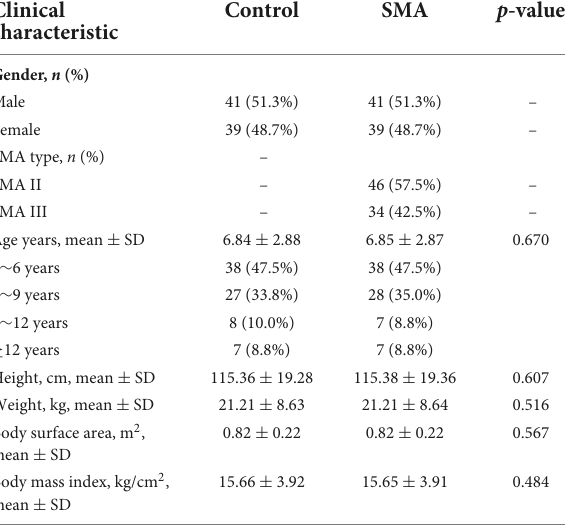
TABLE 1 Demographic and anthropometric data of SMA and control groups.